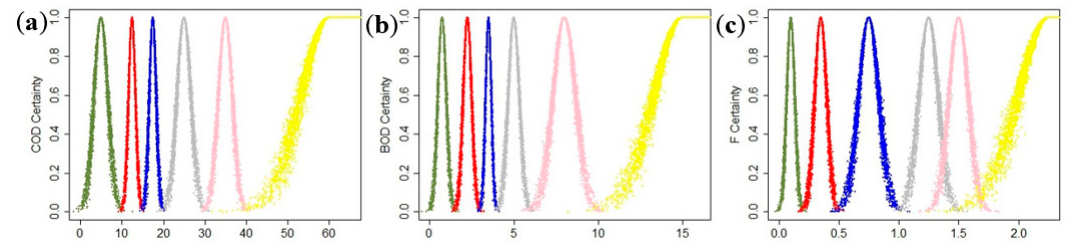
Figure 8. The modified forward cloud corresponding to different water quality grades of ( a ) COD, ( b ) BOD, and ( c )